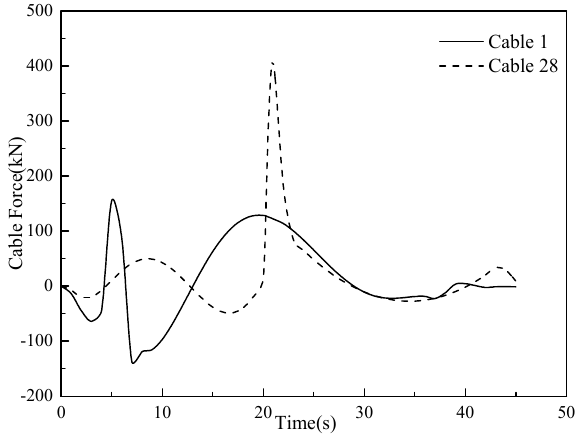
Figure 4. Influence lines of cable 1 and cable 28 on car lane 4.